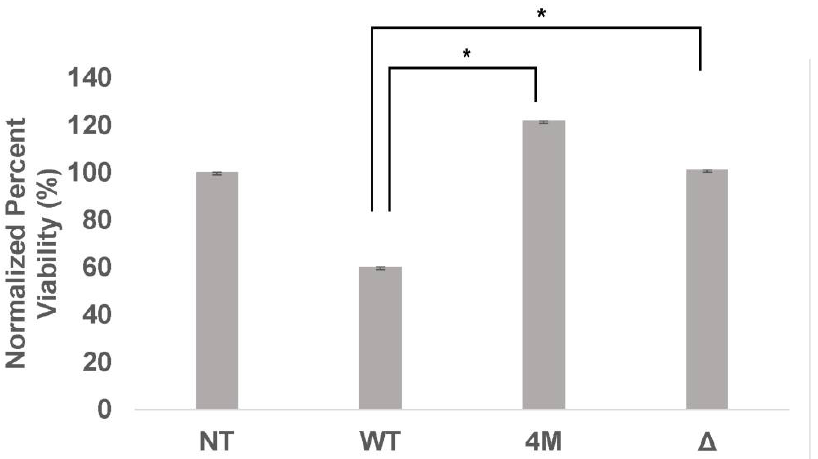
Figure 8. Quadruple and truncated MEK3 mutants exhibited less suppressive activity on the viability of HEK293 cells. HEK293 cells were non-transfected (NT) or transiently transfected concurrently with WT-cMYC or MEK3-cMYC mutant constructs (4M-MEK3 and Δ-MEK3). Cell viability was measured at 24 h using MTS. Values from two independent experiments are presented as percent viability (mean ± SEM). One-way ANOVA with post hoc Tukey’s test for multiple comparisons was used to determine statistical significance *, p < 0.01.